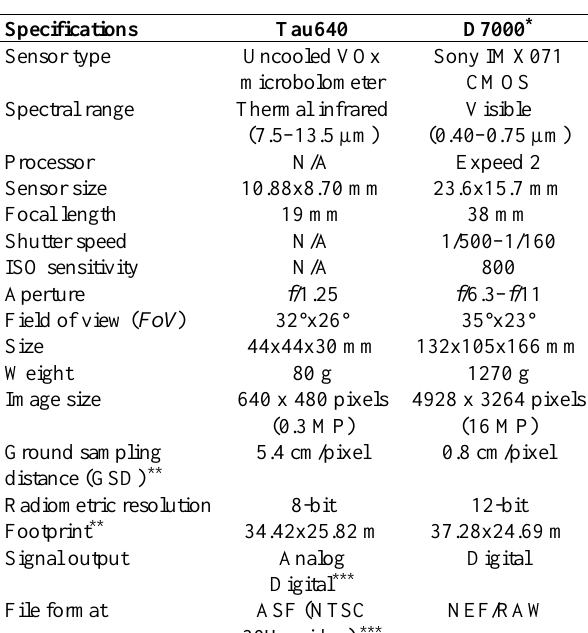
Table 2. Sensors